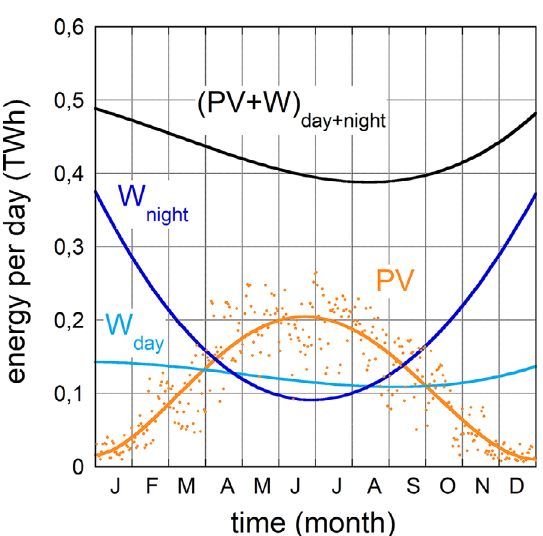
Fig. 4. – Daily energy generation by wind and PV power through the year 2018. For PV, the actual data points are shown along with a polynomial fit to guide the eye. For wind power and the sum of wind and PV, only the fits are given to simplify the diagram. For wind, day and night generations are separately shown. Definition: a day starts or ends when PV has reached 5% of peak power of this day (see main